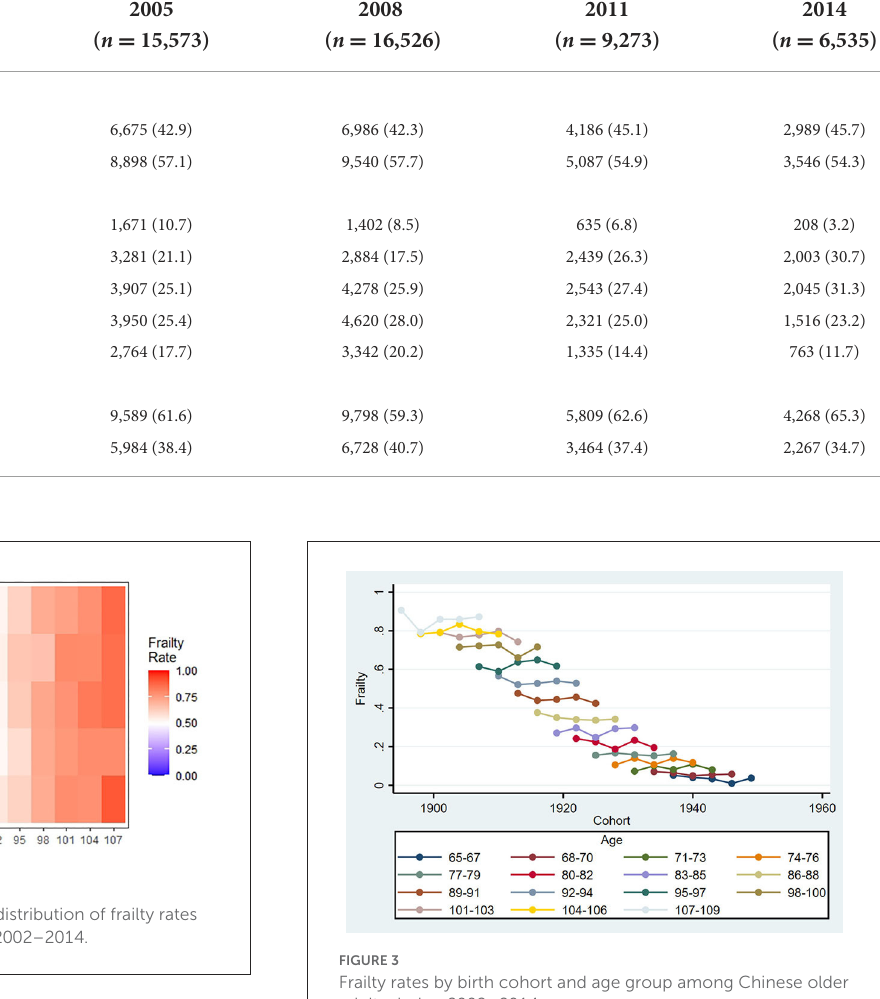
confound the age, period, and cohort effects, it can be tentatively judged that the prevalence of frailty in older adults in the same age group differed across birth cohorts and